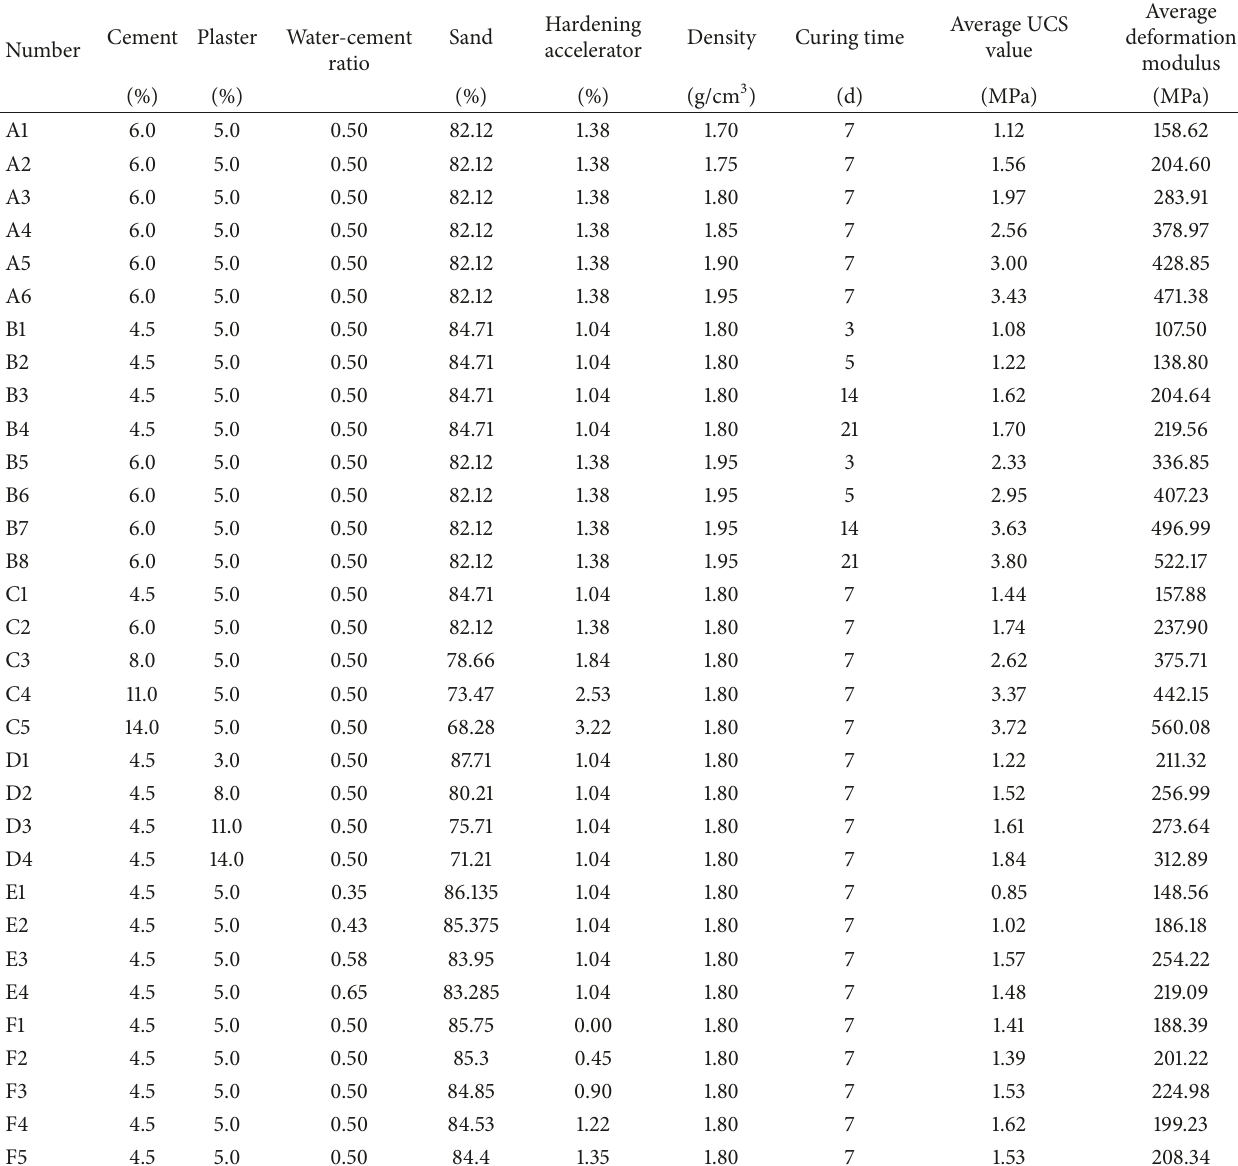
Table 1: UCS testing programs and